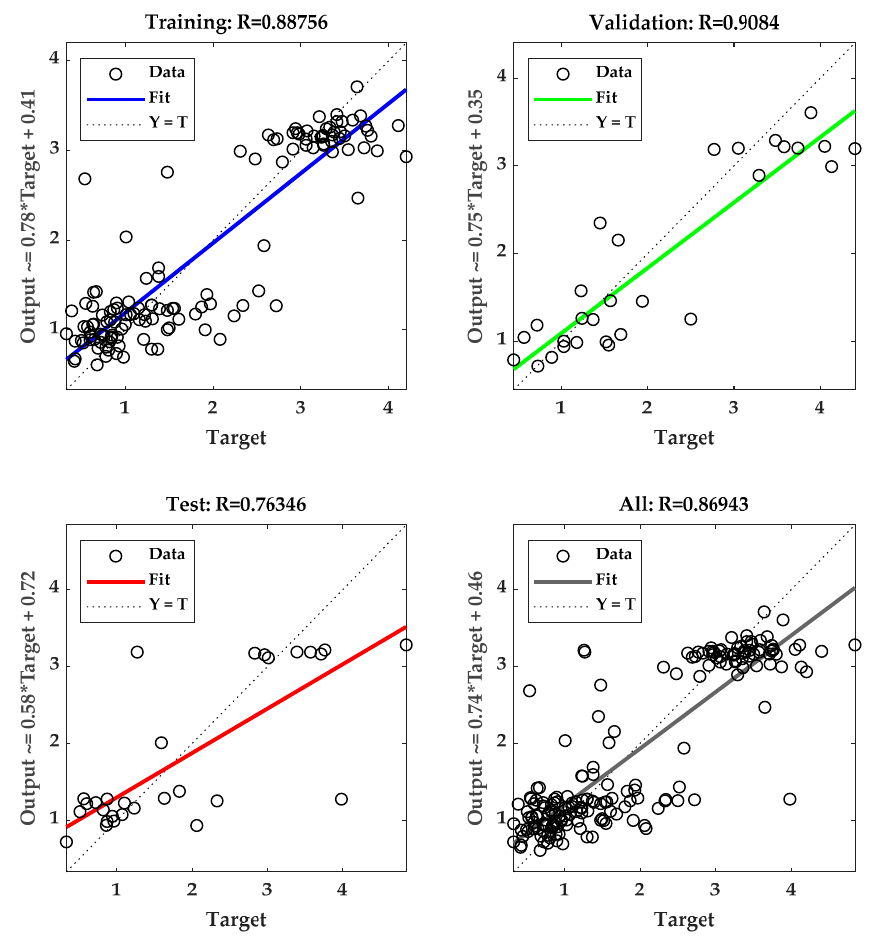
Figure 5. Regression results of the BP neural network model.